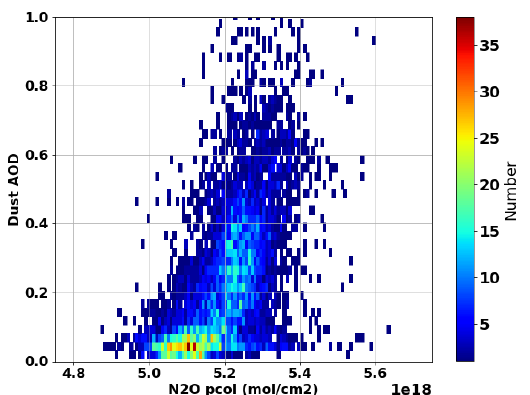
Figure 6. Correlation between the MAPIR [77] dust AOD and our retrieved N 2 O partial column along the retrieval vertical range, for the 1st of June 2018 in the Saharan area (latitude 15 to 35° N, longitude 30° W to 30°